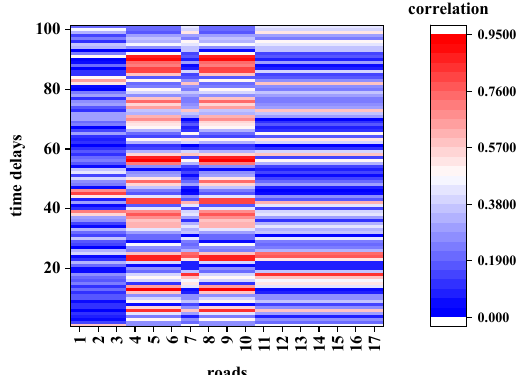
Figure 10. Correlation determined using the improved CCF.